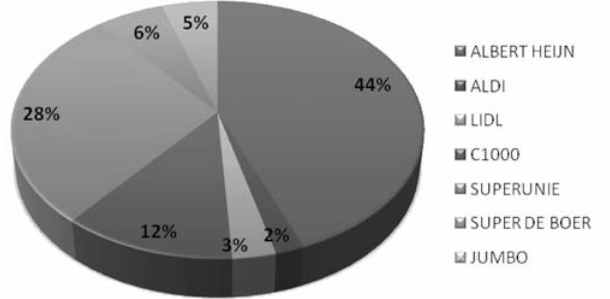
Figure 3. Supermarket sales of pre-treated fresh vegetables in 2010 (value) Source: PT / Nielsen